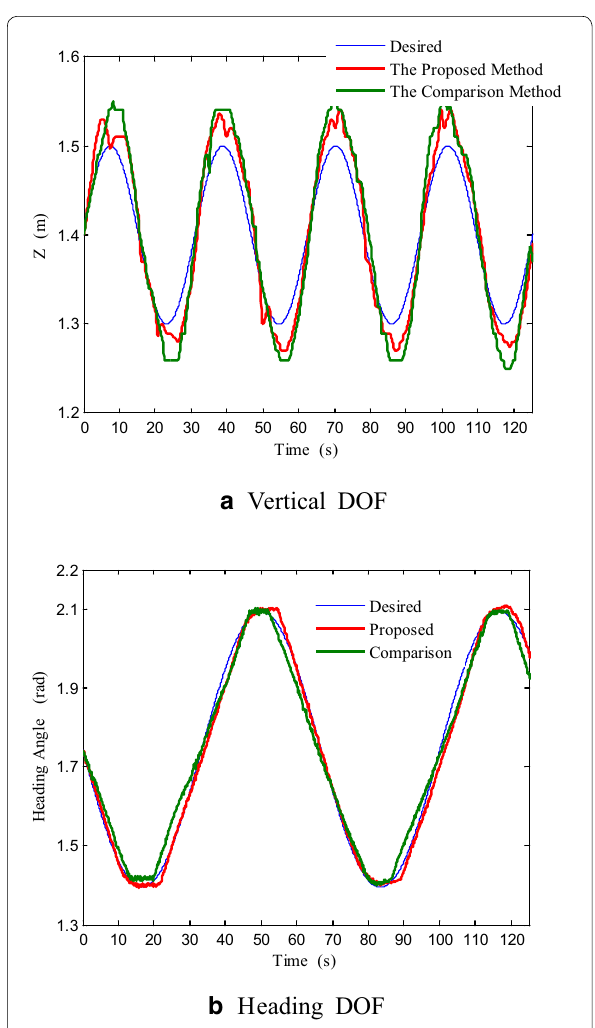
Figure 10 Continuous target trajectory tracking in 0.3 m/s ocean current